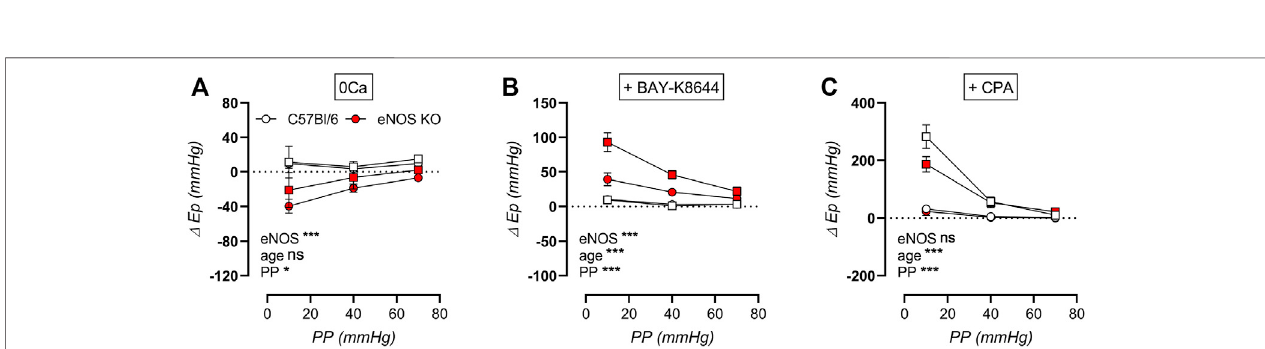
FIGURE12| StretchdependencyofVSMCtoneandintracellularcalcium.Aorticringsofyoung(4 months, n =6)andaged(13 months, n =4)eNOSknockoutand young (4 months, n = 6) and aged (14 months, n = 4) C57Bl/6 control mice were subsequently exposed to 5 min of cyclic stretch at low (10 mmHg), physiological (40 mmHg), and high (70 mmHg) pulse pressure (PP). Extracellular calcium was removed using 0Ca Krebs Ringer solution to abolish active VSMC tone (A) . Aortic rings were stimulated with 30 nM BAY-K8644 (B) or 10 µM CPA (in the presence of 300 μ M L -NAME) (C) in baseline Krebs-Ringer conditions. Statistical analysis was preformed using thee-way ANOVA. Only the overall signi fi cance (bottom) is listed. ns, p > 0.05; *, p < 0.05; ***, p < 0.001.